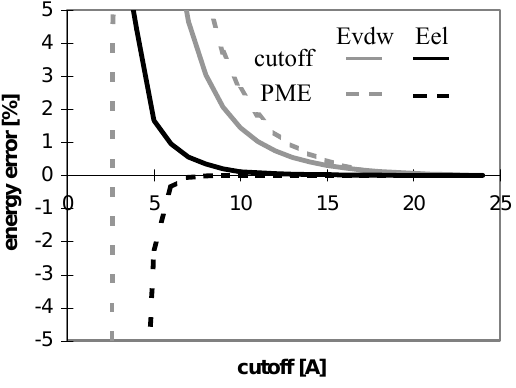
Figure 4. Dependency of energy error on cutoff for peptide P2 in explicit solvent. For description of energy error see Figure